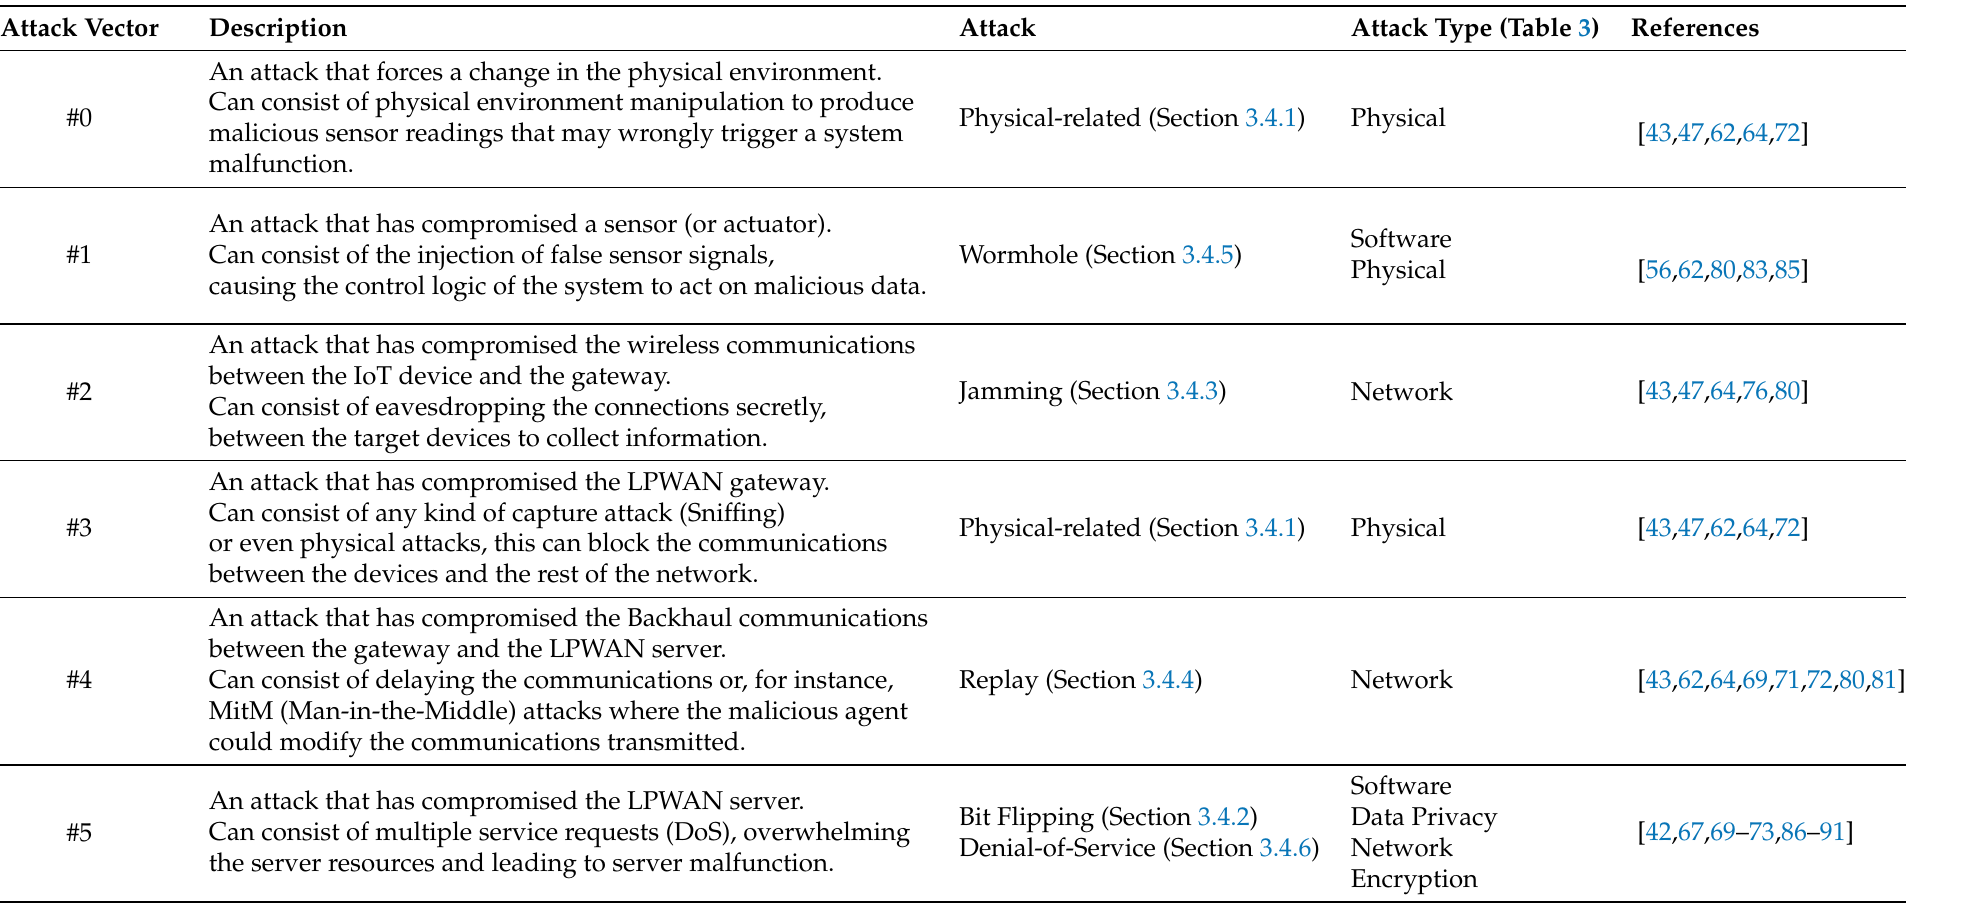
Table 4. Attack Vectors and their characterization according to Figure